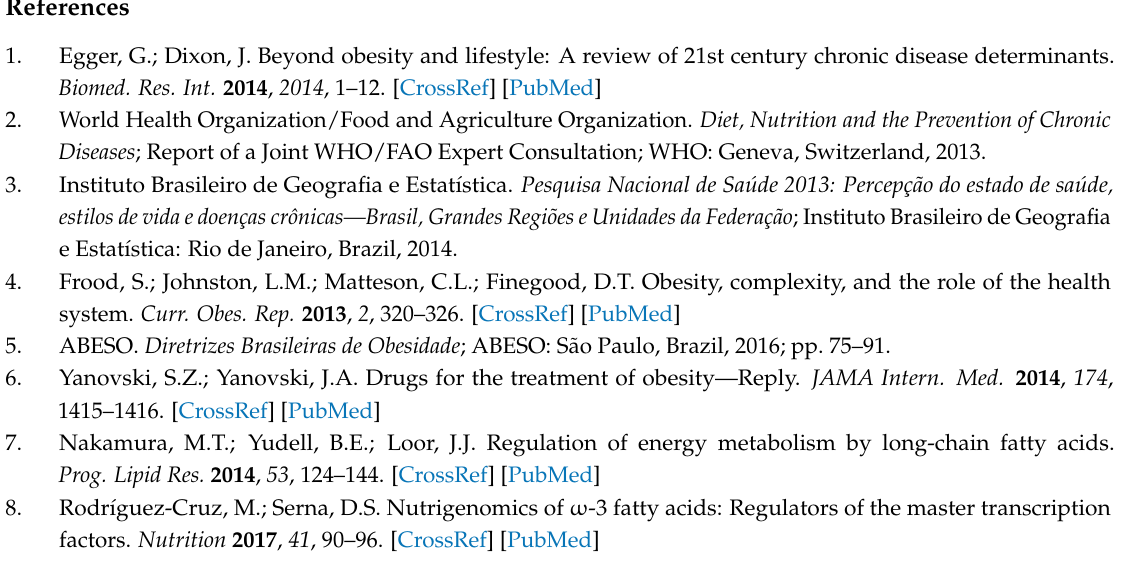
Table S1: Centesimal Composition of the oils used in the study. Table S2: Description of anthropometric and biochemical